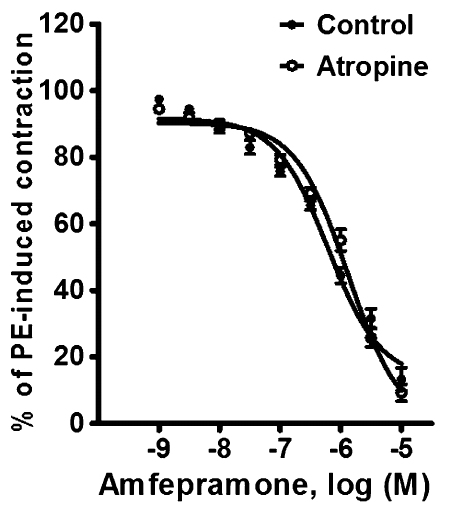
Figure 3. Effects of 10 –6 M atropine on amfepramone-induced vasorelaxation in rat aortic rings with functional endothelium and precontracted with 10 –6 M phenylephrine (PE). Data are reported as means±SE of n=6 observations. P . 0.05 vs control (two-way repeated-measures